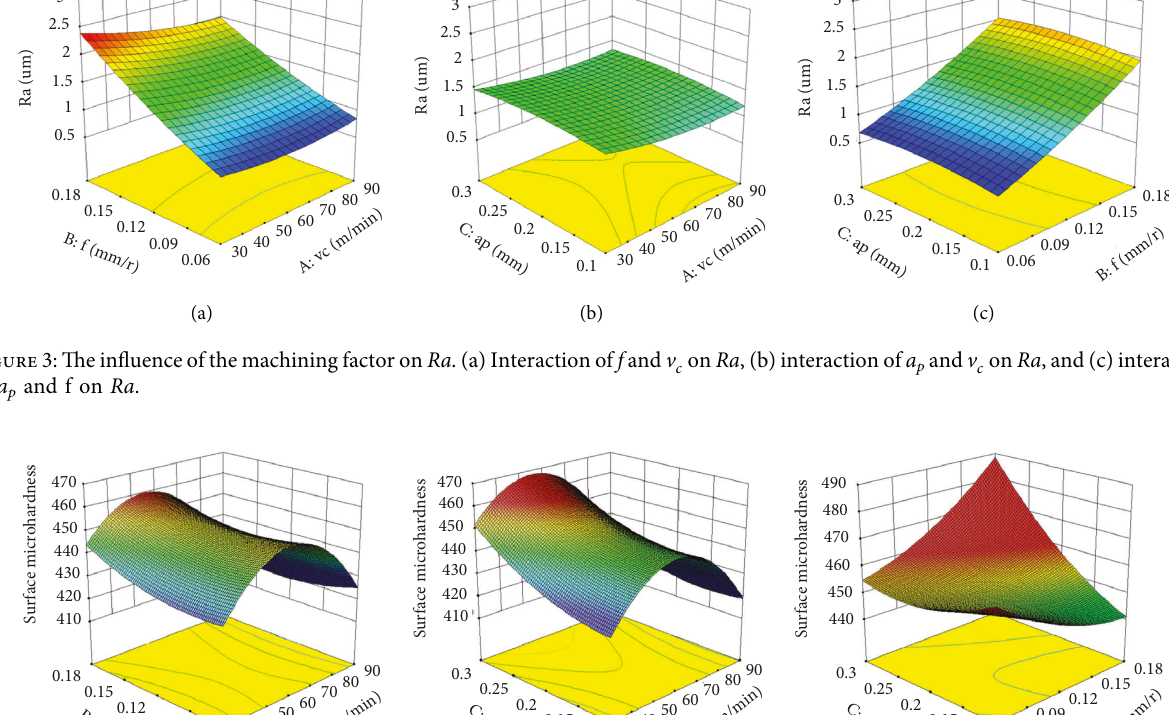
v c on HV . (c) The